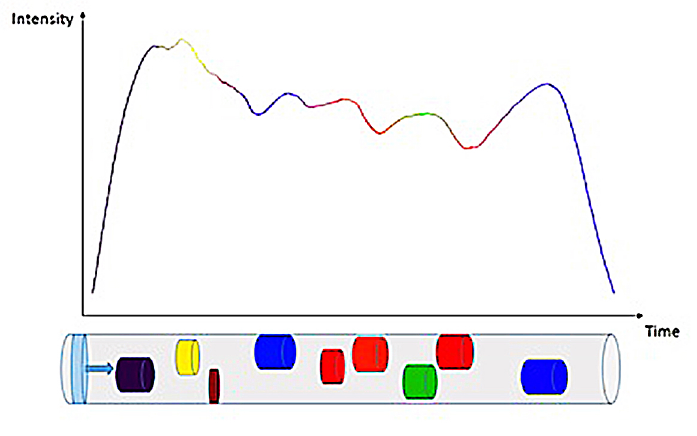
Figure 4. Illustration of a simulated micro-variability curve and a possible distribution of turbulent cells from which the light curve originates. The shock is on the left and propagates down the jet to the right accelerating particles as it encounters the turbulent cells. The radial positions of the cells are arbitrary since we have no depth